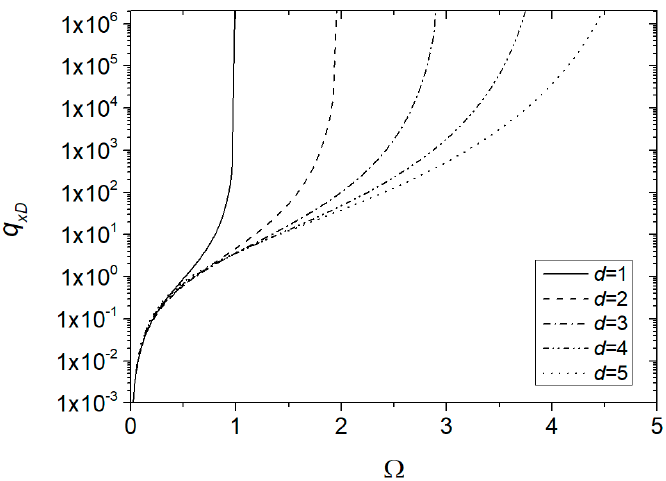
Figure 5. Dimensionless flow rate per unit width q xD versus dimensionless pressure gradient Ω for di ff erent values of the distribution parameter d .